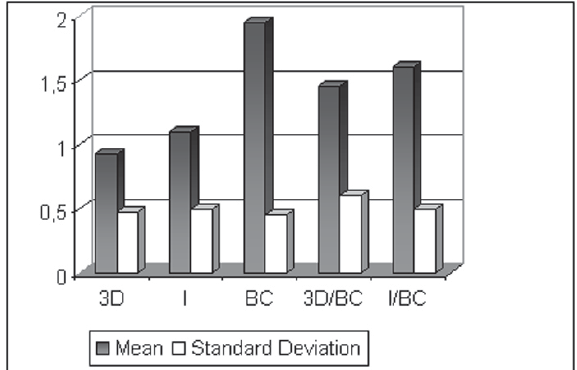
FIGURE 3- General mean and standard deviation of the tools for image